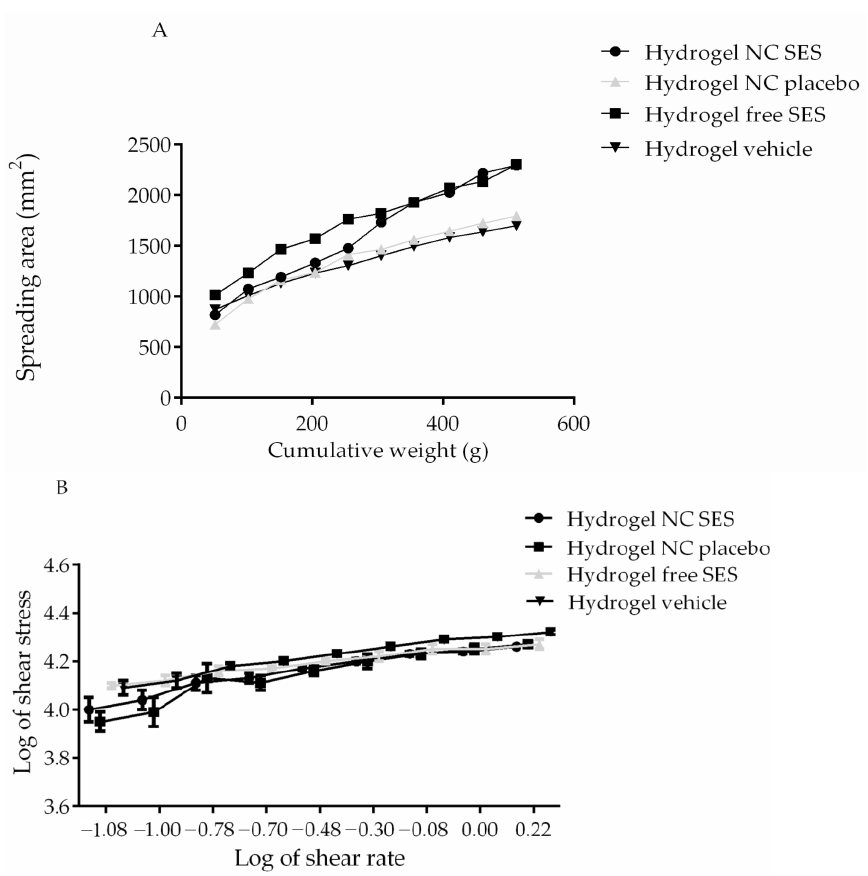
Figure 6. Spreadability ( A ) and Ostwald-de-Waele model ( B ) profiles of the hydrogels. The experi- ment was performed in triplicate for each hydrogel, and the values are reported as the mean ± SD. All data were analyzed by ordinary one-way ANOVA at each point (individual shear rate) ( p > 0.05). Table 3. Regression coefficients (r 2 ) and mathematical equations to models of Bingham, Casson, and Ostwald-de-Waele.